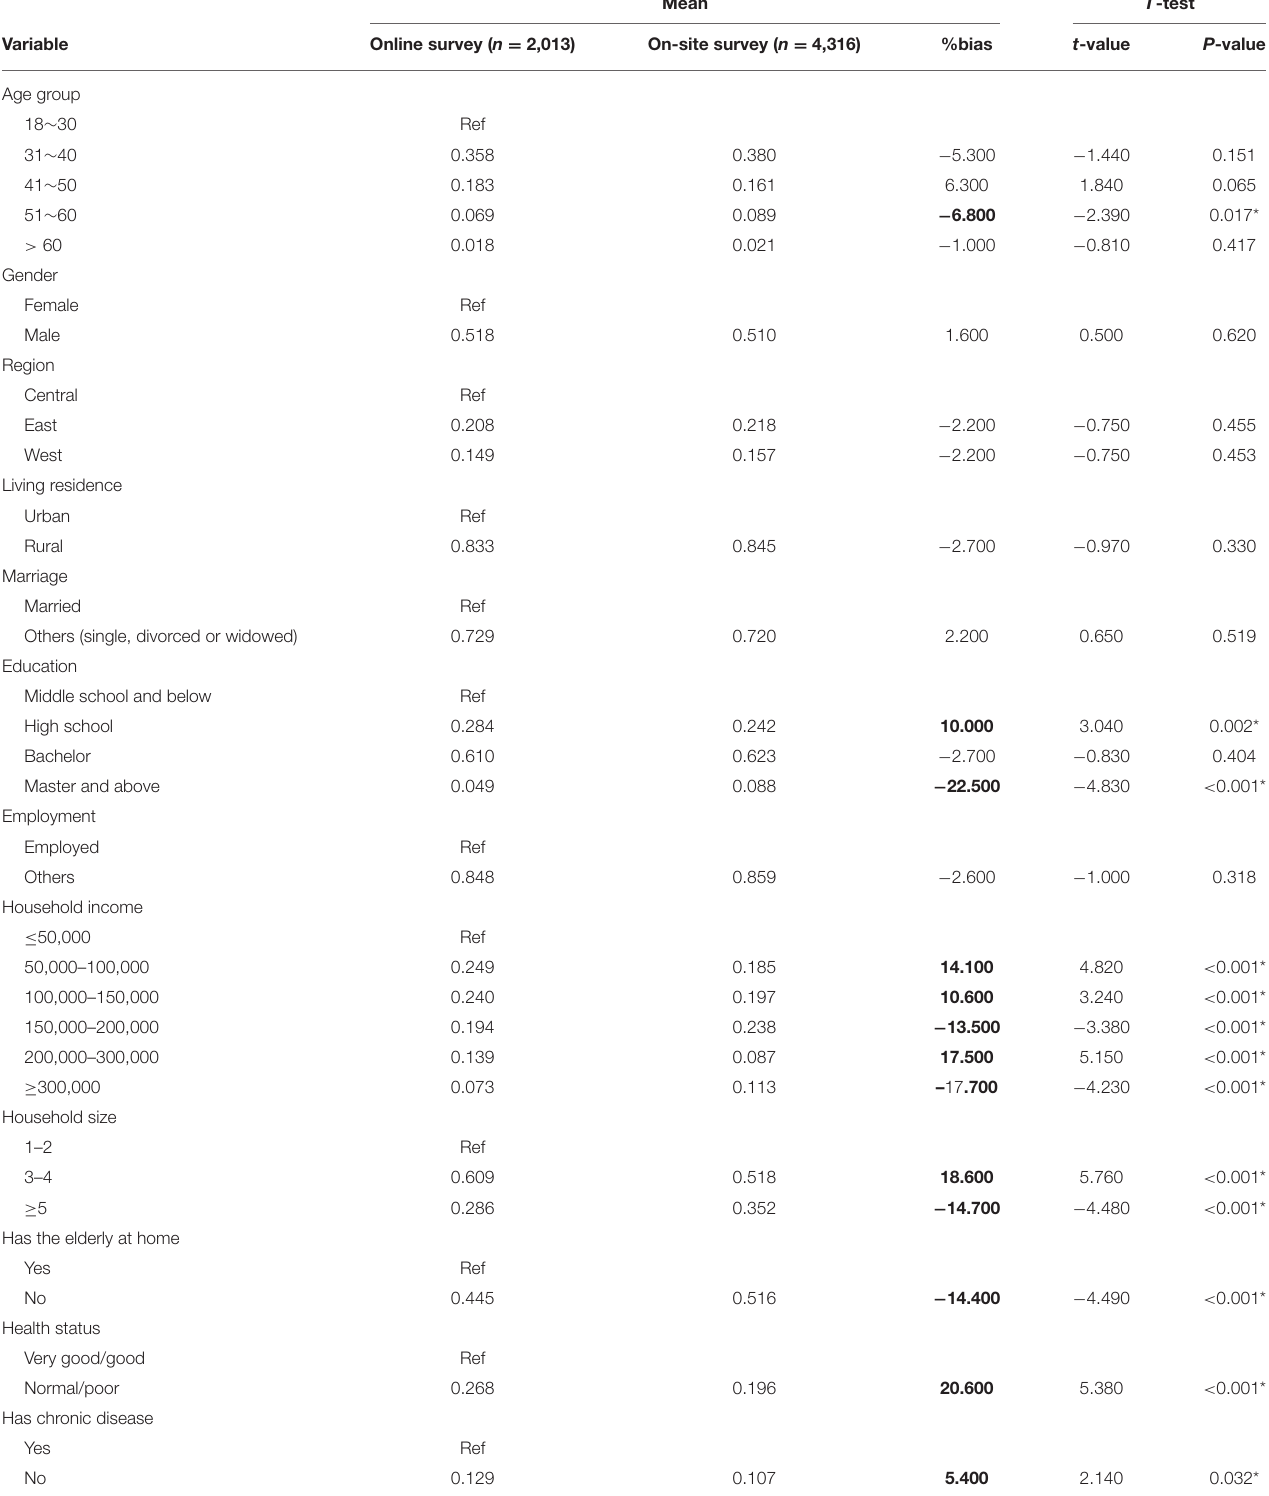
TABLE 5 | PSTEST results to examine whether the matched results could balance the differences of covariates under online and on-site